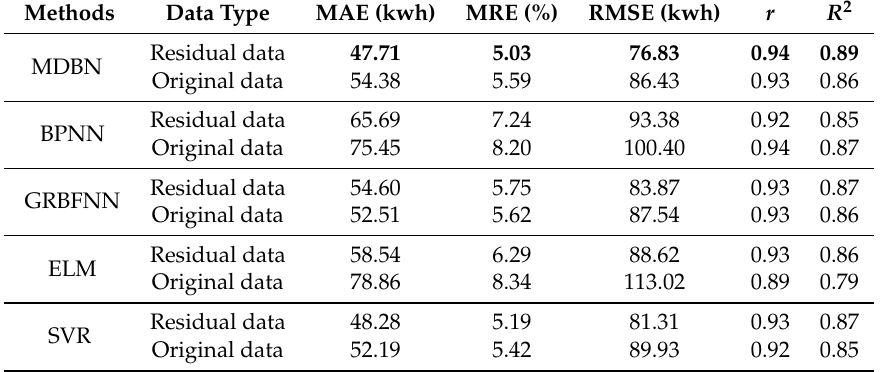
Table 3. The performances of the five models for the retail store energy consumption prediction.